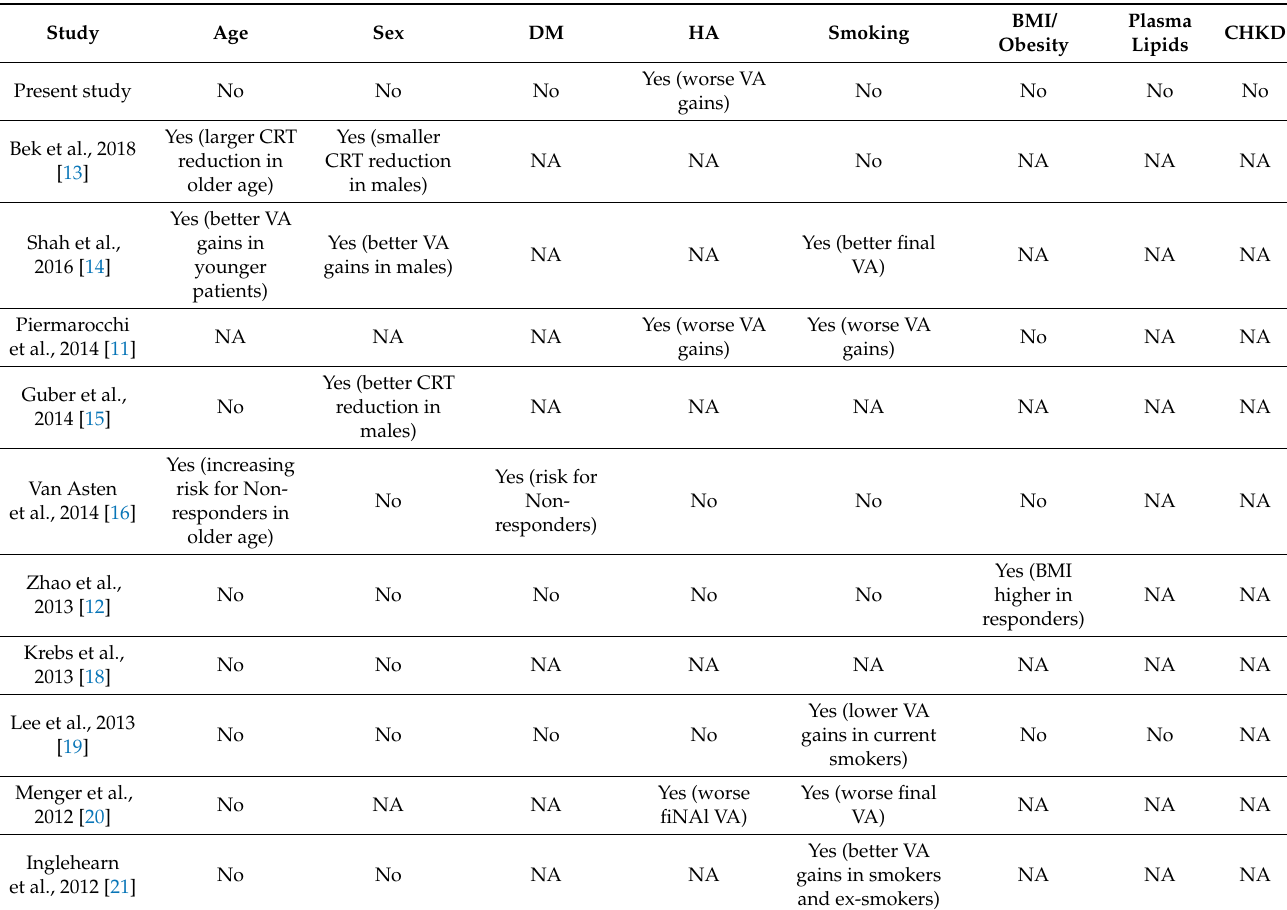
Table 7. Presence or absence of statistically significant correlations between the presence of selected systemic risk factors and the response to anti-VEGF treatment of